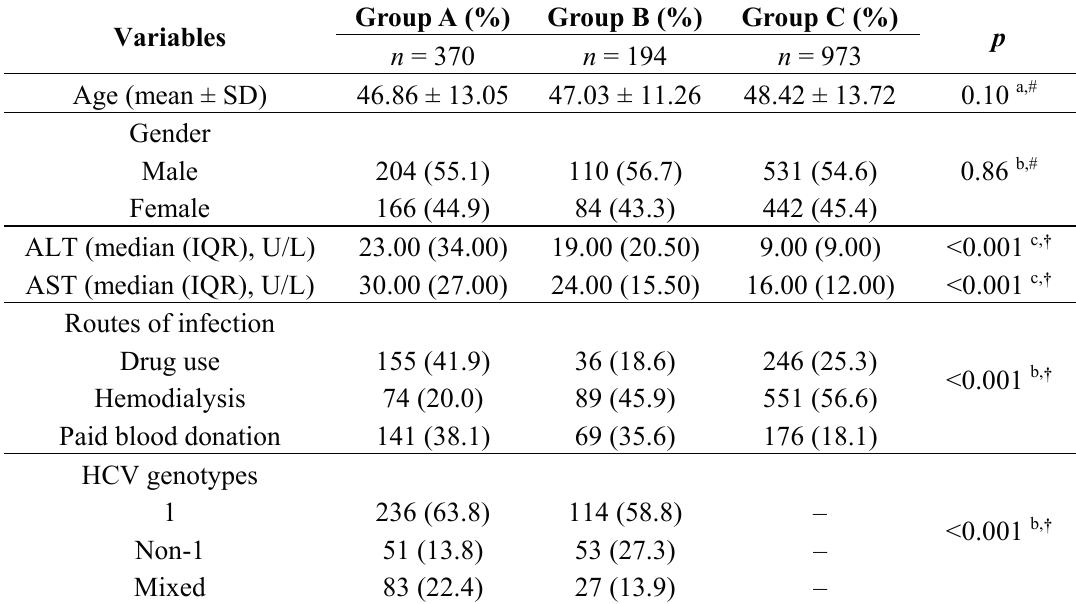
Table 1. Demographic and clinical characteristics of Hepatitis C virus (HCV) persistent infection, spontaneous clearance and healthy control